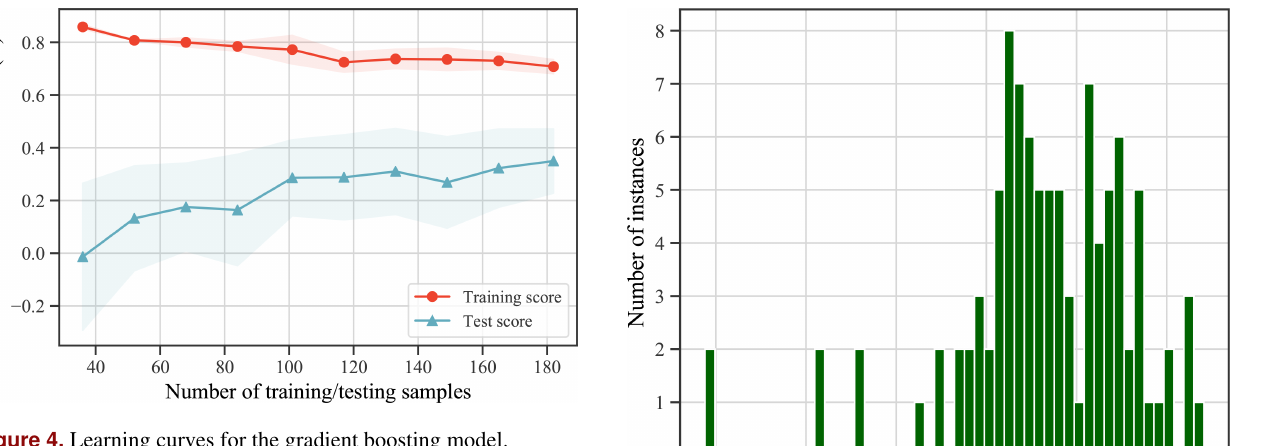
Figure 4. Learning curves for the gradient boosting model.